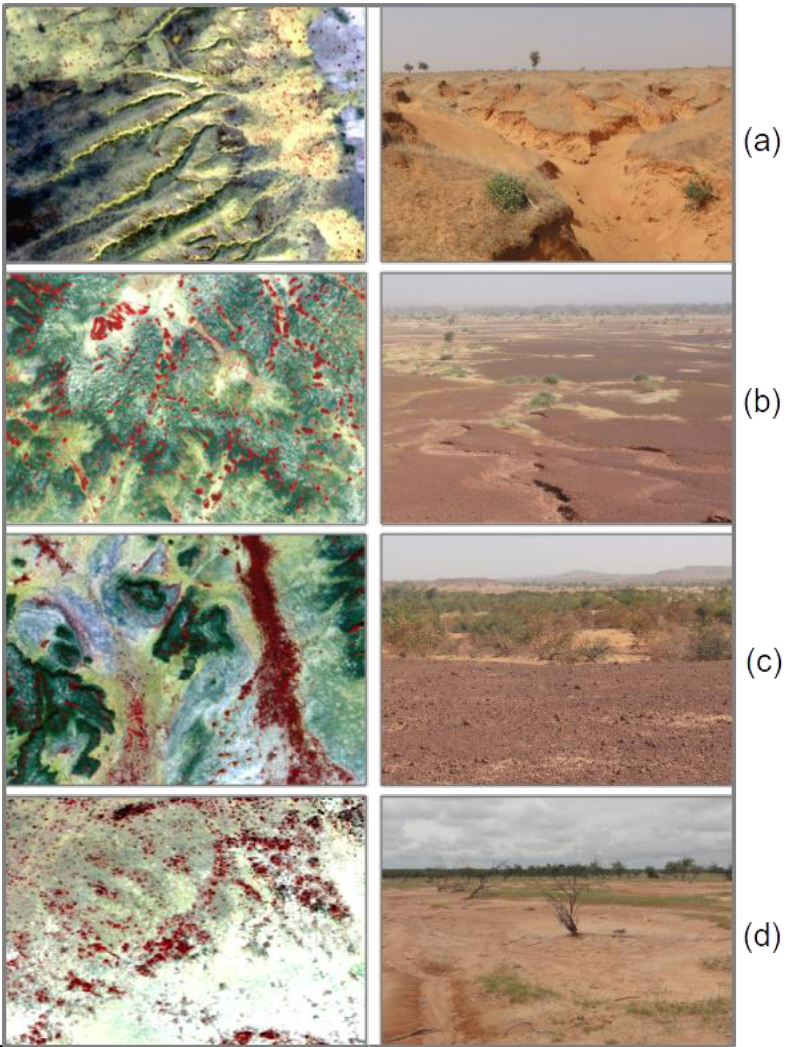
Figure 3. Matched satellite images and ground photos of degradation phenomena in the Sahel: ( a ) Water erosion with gullies. ( b ) The loss of woody vegetation (red color in RapidEye) caused by poor management and climatic changes induces wind/water erosion of fertile topsoil (bright yellow color) and leaves only stony laterite (dark gray color). ( c ) Outcropping of hard rocks (black color) caused by soil degradation and forest/tree loss. ( d ) Clogging of ferruginous soils (white color), loss of topsoil and woody (red) and herb vegetation (gray) caused by overgrazing/trampling. RapidEye composites (bands 5-3-2) (left) and photos (right): ( a–c ) Mali December 2011, ( d ) Senegal September